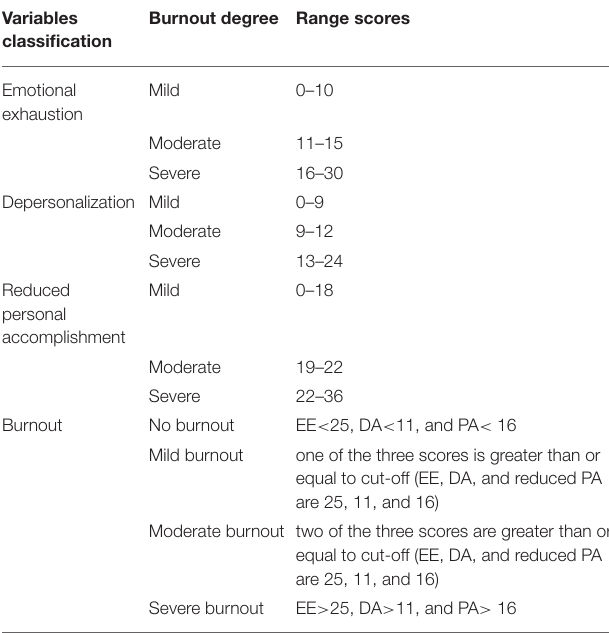
TABLE 1 | The cut-off scores for burnout three dimensions. Variables